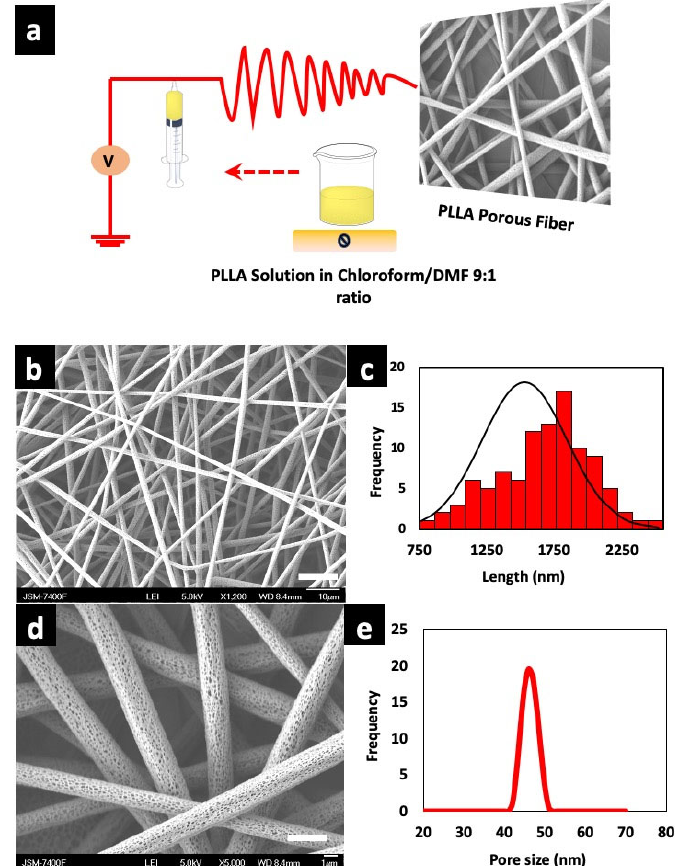
Figure 1. ( a ) Fabrication protocol of poly (l ‐ lactic acid) (PLLA) porous scaffolds and schematic illustration of electrospinning device. ( b ) Scanning electron microscope (SEM) micrographs of as fabricated fibers (scale bar = 10 µ m). ( c ) Corresponding diameter distribution of the fibers. ( d ) PLLA fiber with highly porous structure (scale bar = 1 µ m). ( e ) Pore size distribution of unmodified fibers